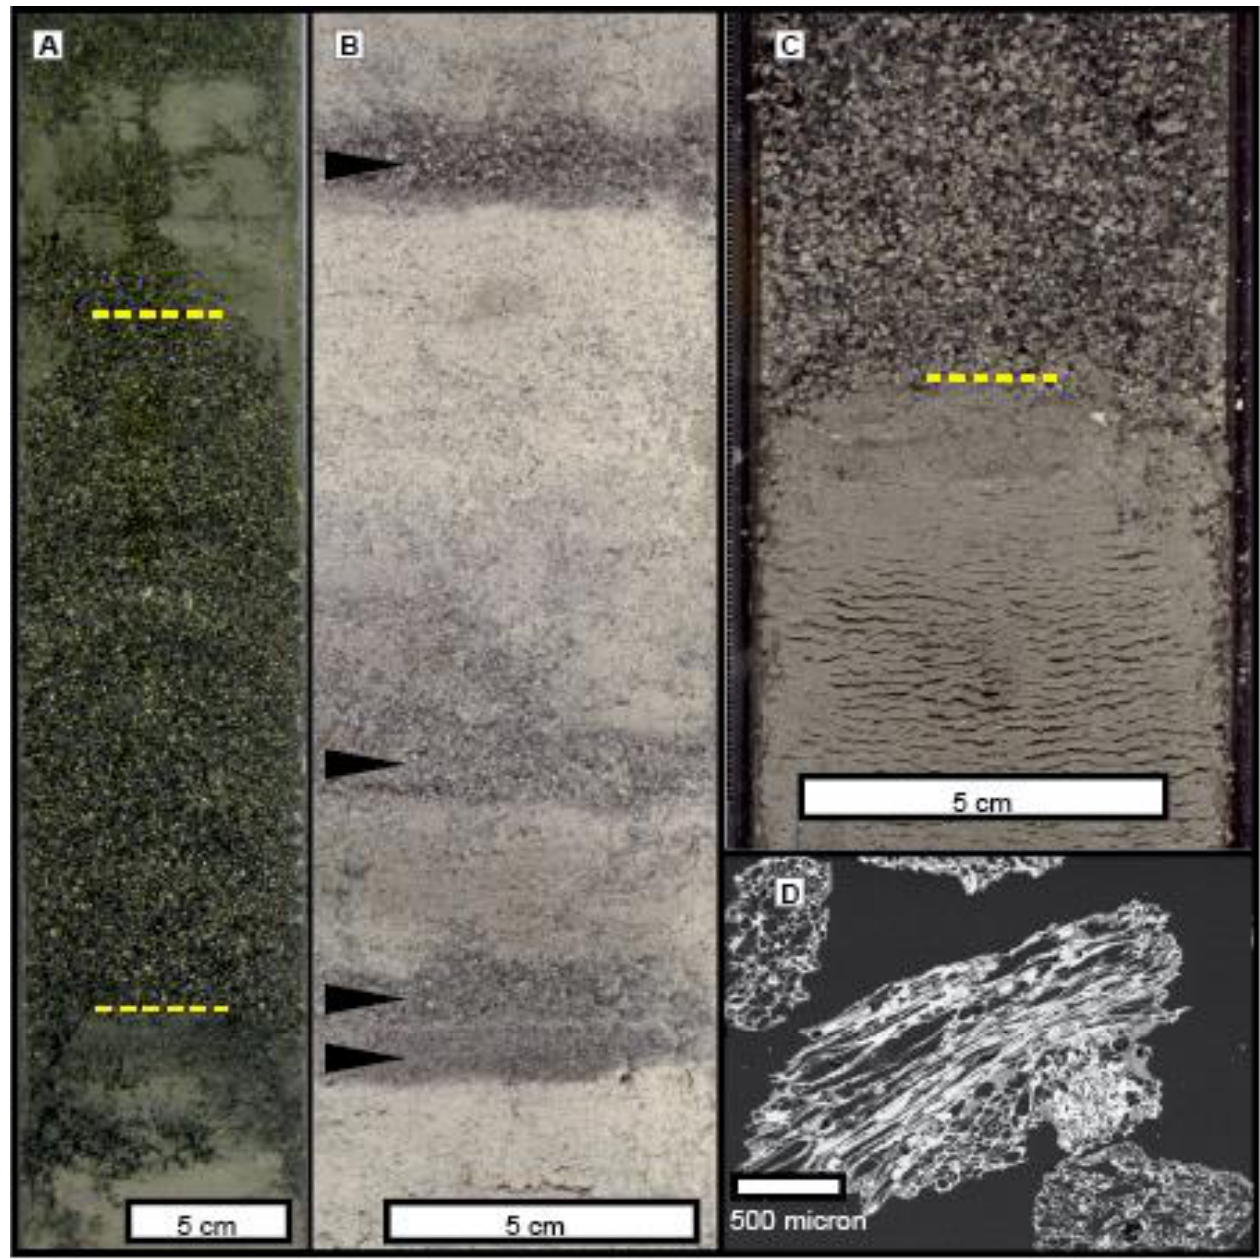
Figure 3. Examples of cored marine volcaniclastic deposits offshore Montserrat, Lesser Antilles. ( A ): An andesitic volcaniclastic turbidite (core JR123-21), bounded by hemipelagic mud, with the main